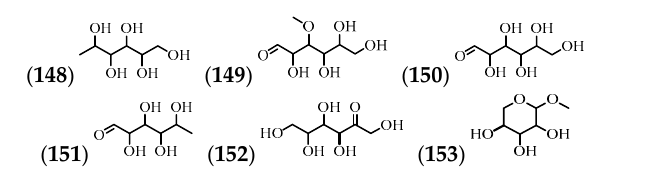
Figure 10. The structures of the carbohydrates from A. cathartica.